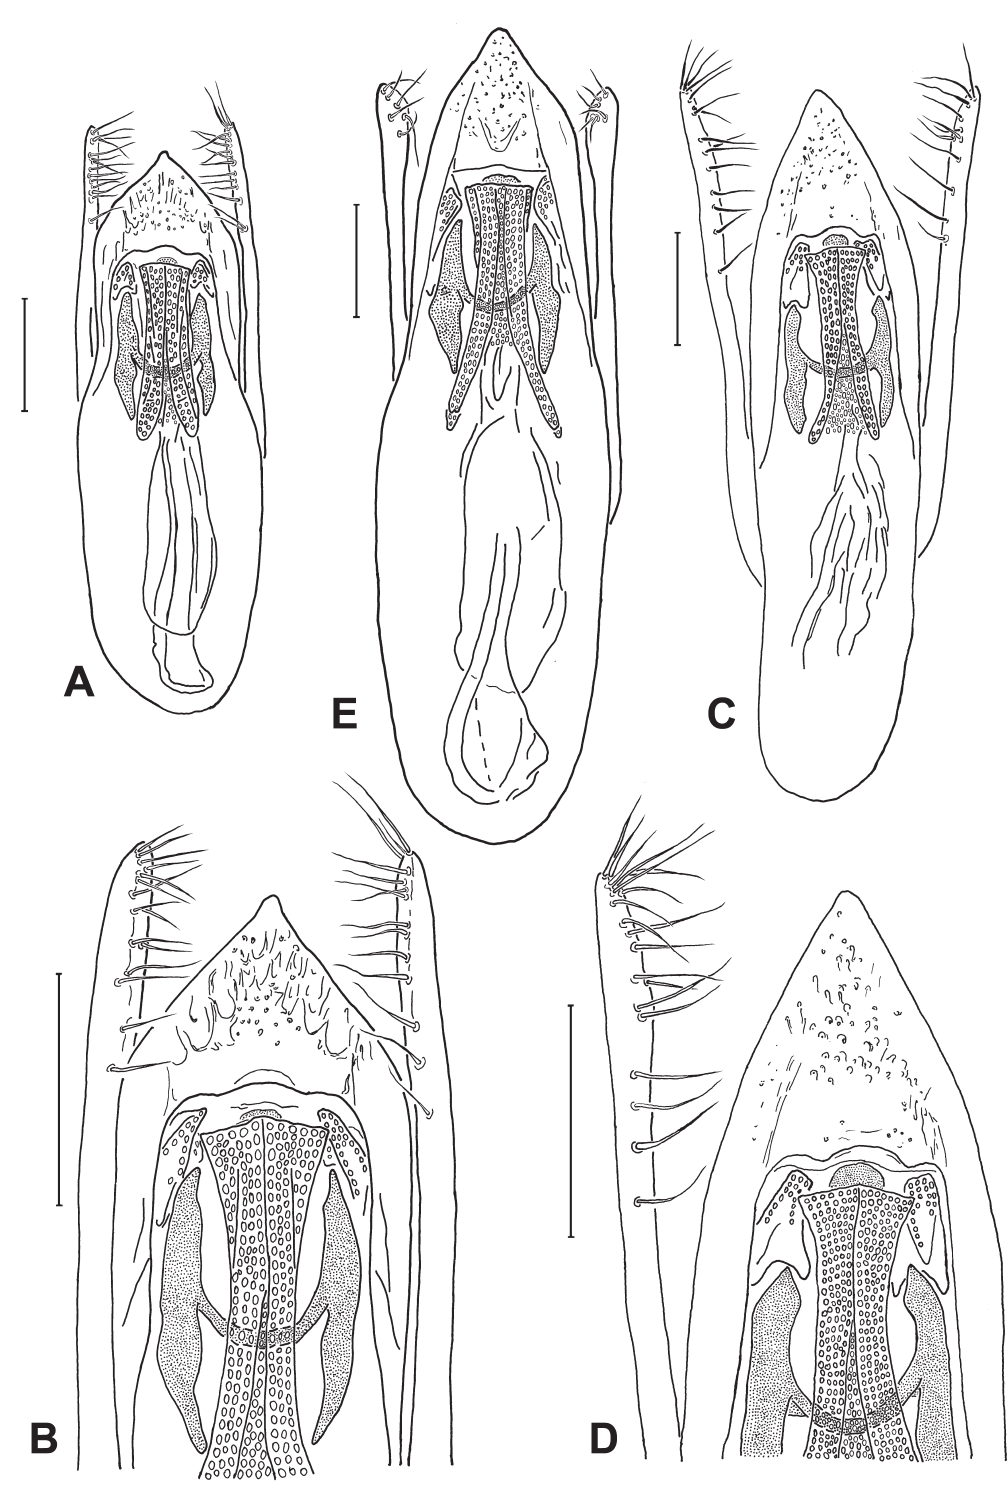
Fig. 2. – A–B : Stenus ( Nestus ) raddei Ryvkin, 1987: ♂ (Russia: Magadan Area: Sibit-Tyhellakh). A . Aedeagus, ventral view. B . Apical part of aedeagus, ventral view. – C–D : S. ( N. ) illotulus Puthz, 1972: ♂ (Russia: Amur Area: Zeyskiy Nature Reserve). C . Aedeagus, ventral view. D . Apical part of aedeagus, ventral view. Right paramere removed. – E . S. ( N. ) confusus J. Sahlberg, 1876: ♂ (Russia: kalinin Area: Putilovo). Aedeagus, ventral view. – Scales = 0.1